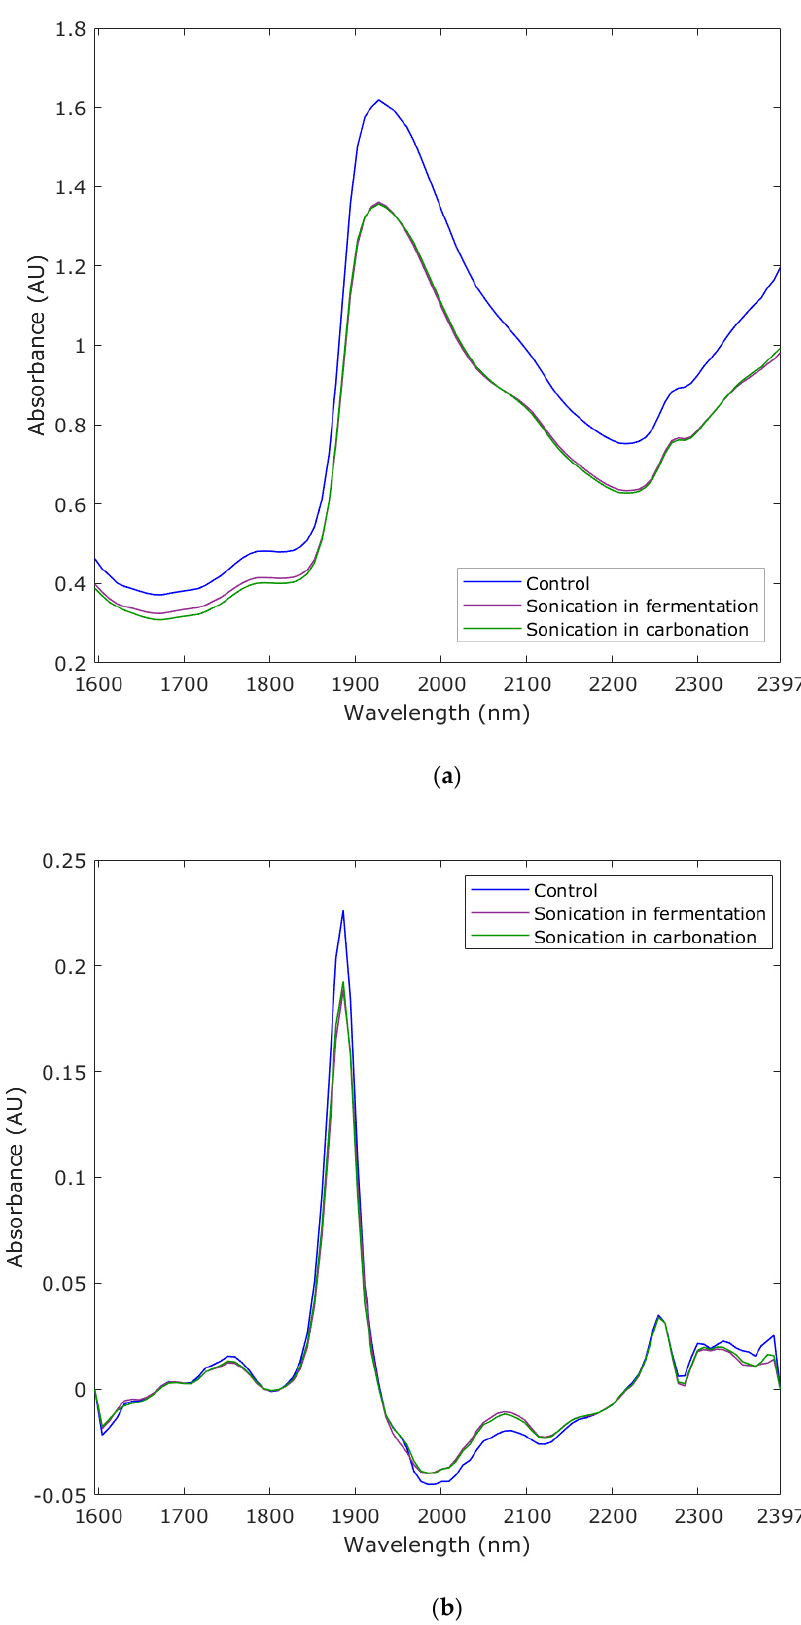
Figure 3. Near-infrared curves showing ( a ) the raw and ( b ) the transformed curves using the first derivative of the absorbance values within the 1597 – 2397 nm range.